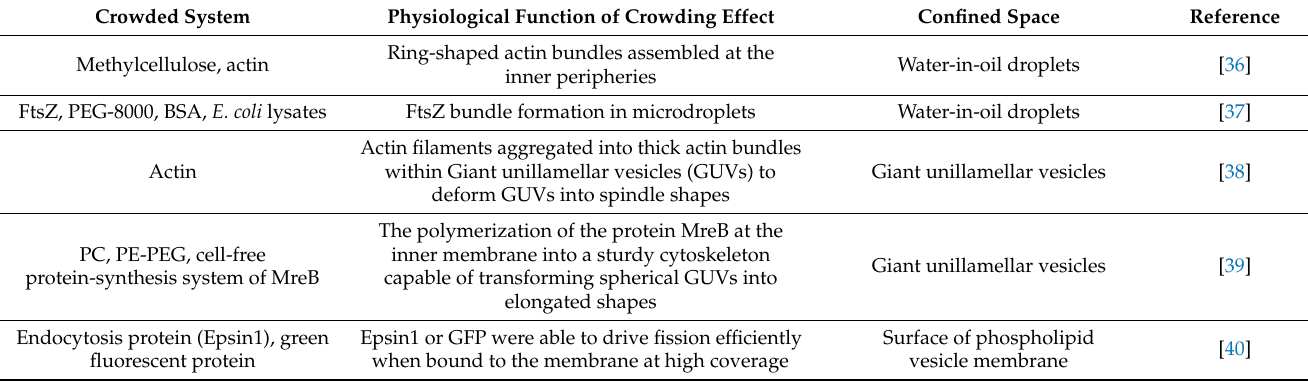
Table 1. Progress of research on crowding effect in cell-like structures.